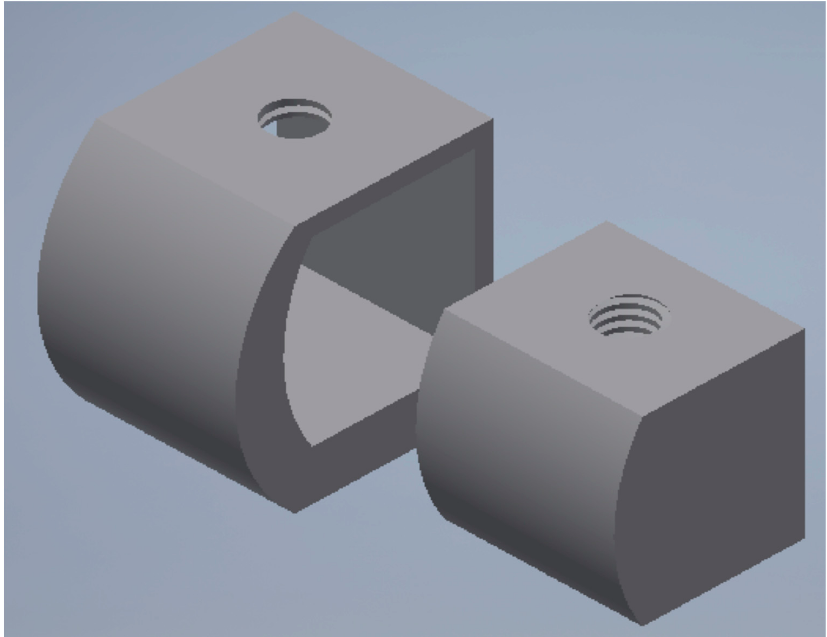
Figure 5. A recreation of mandibular bone. External cortical bone and internal midollar bone.